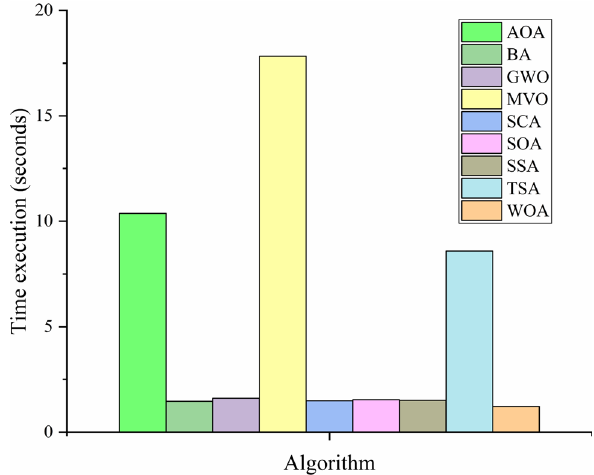
Fig. 19 The time execution of the algorithms for case 1